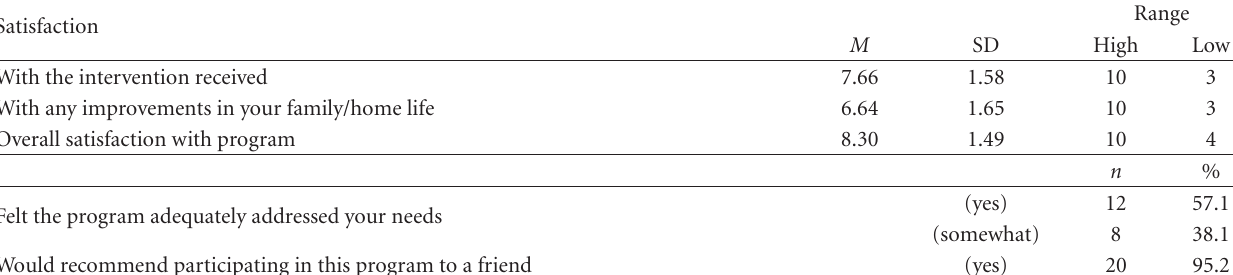
Table 3: Results of consumer satisfaction survey for parents participating in BEST-Plus ( n =